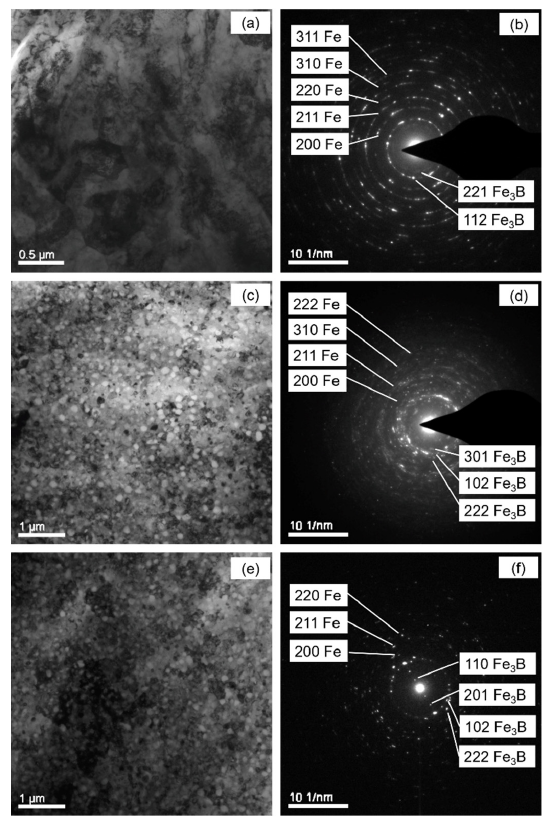
Figure 3. Bright field micrograph of TEM and SAEDPs of the crystallized Fe 85 B 15 amorphous alloy after heated at 5 K min − 1 (( a ) and ( b )); at 20 K min − 1 (( c ) and ( d )) and at 40 K min − 1 (( e ) and ( f )). The diameter for α -Fe (bcc) and tetragonal Fe 3 B phases have been identified in the SAEDPs ( b , d , f ).